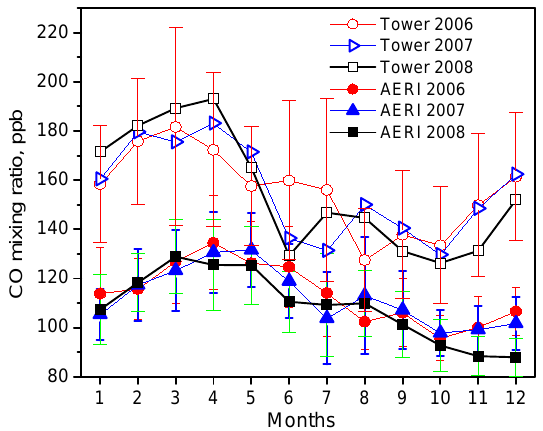
Fig. 13. Anomalies of monthly mean CO retrieved by the AERI v2 referenced to the seasonal cycle calculated from the period from January 2004 through December 2007. Plotted for compar- ison are AIRS-derived total column CO anomalies for the NH (be- tween 30 ◦ N and 70 ◦ N), North America (bounded by 30 ◦ N, 70 ◦ N; 60 ◦ W, 170 ◦ W), and the tropical belt (30 ◦ S–30 ◦ N) corrected ac- cording to Yurganov et al.